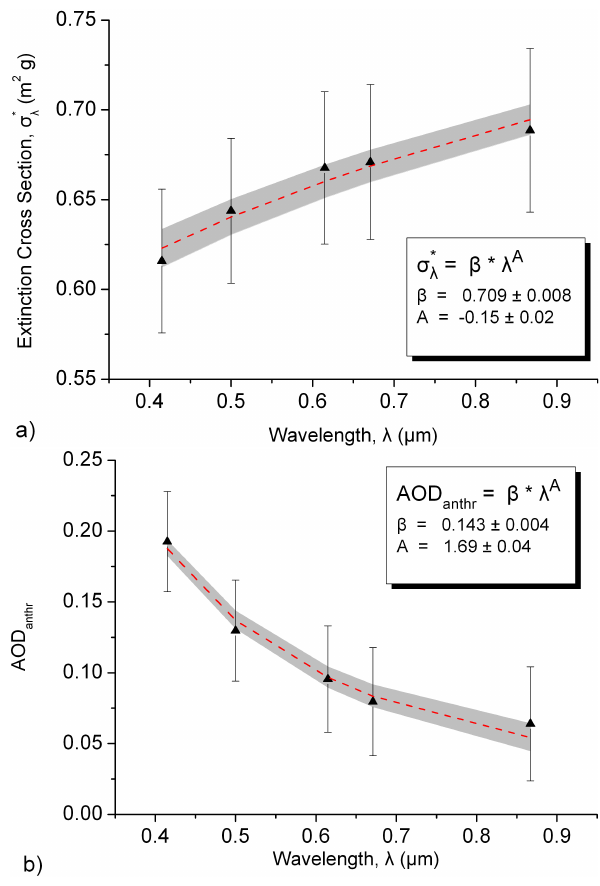
Fig. 3. Fitting of the ˚Angstr¨om equation on (a) the extinction cross- sections calculated for different wavelengths as the slopes of re- gression analysis as in Fig. 2 and (b) the intercepts of the respective regression analysis for different wavelengths (values are taken from Table 1). The error bars correspond to the standard error of each point and the shaded area denotes the limits of the 95% confidence level of each fitting